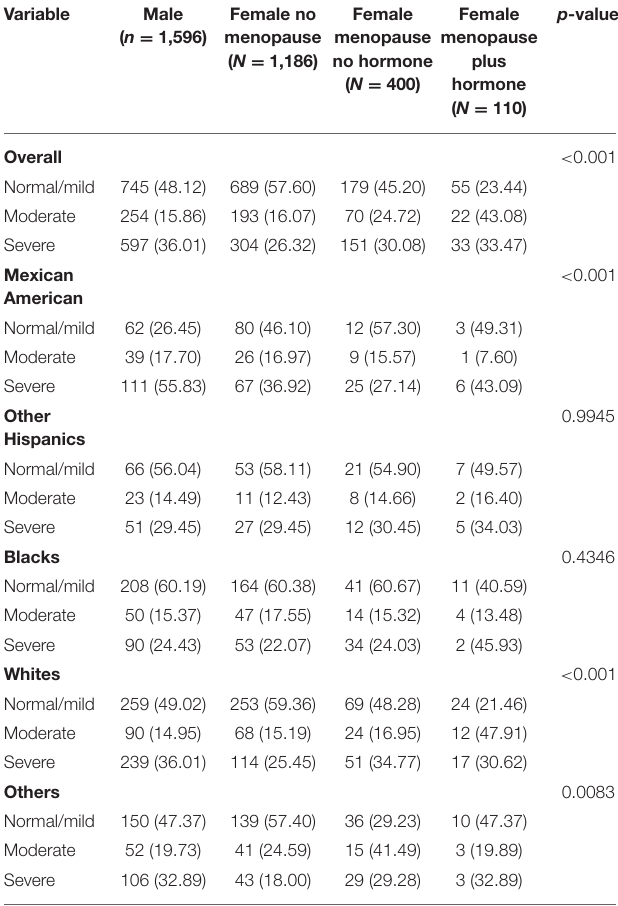
TABLE 3 | Age-adjusted prevalence of NAFLD stage by race/ethnicity and